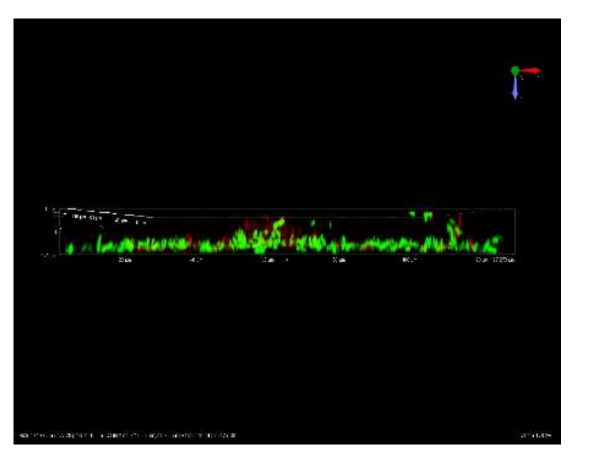
Figure 3. Representative CLSM image of L. monocytogenes ATCC 7644 cellular aggregates after exposure to 250 µ L mL − 1 CHY for 1 h at 37 ◦